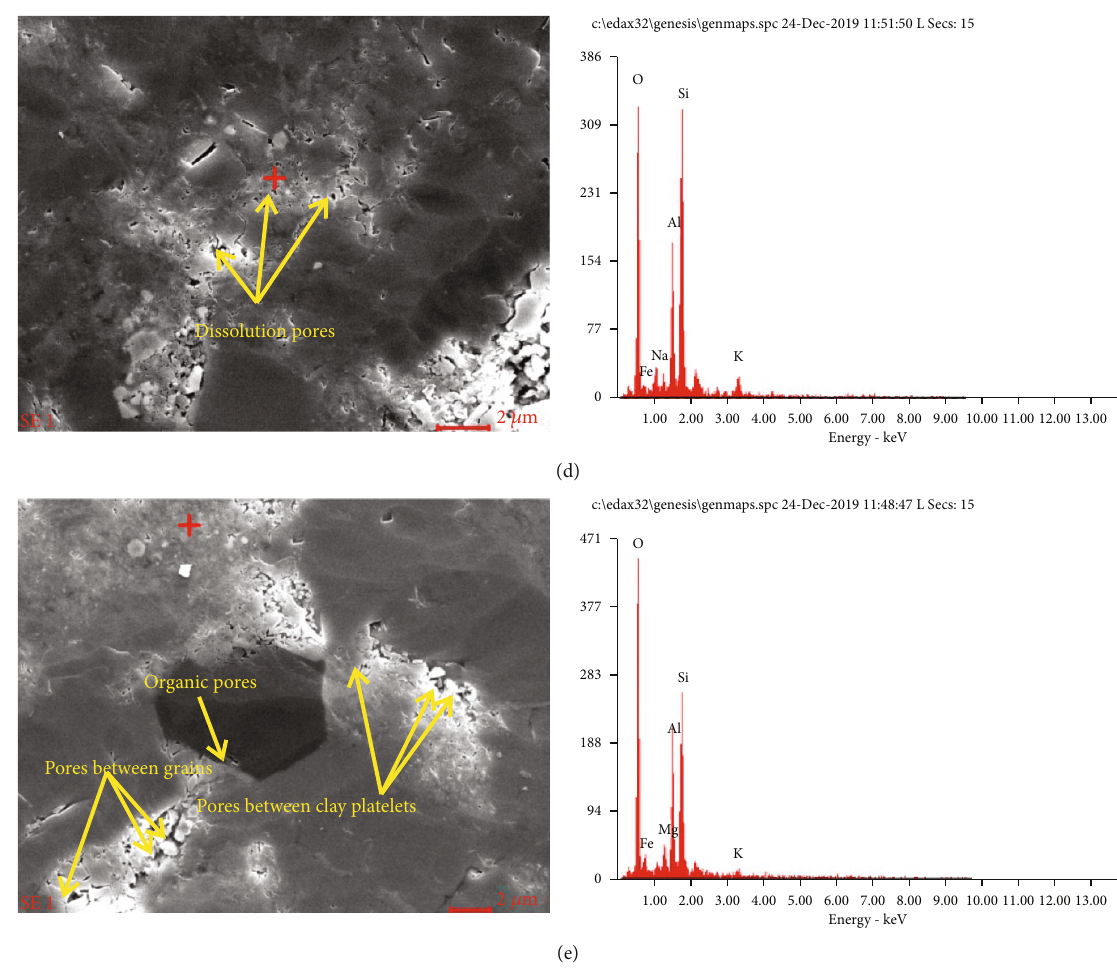
Figure 5: Scanning electron microscopy and energy-dispersive X-ray spectroscopy images of shale samples of K